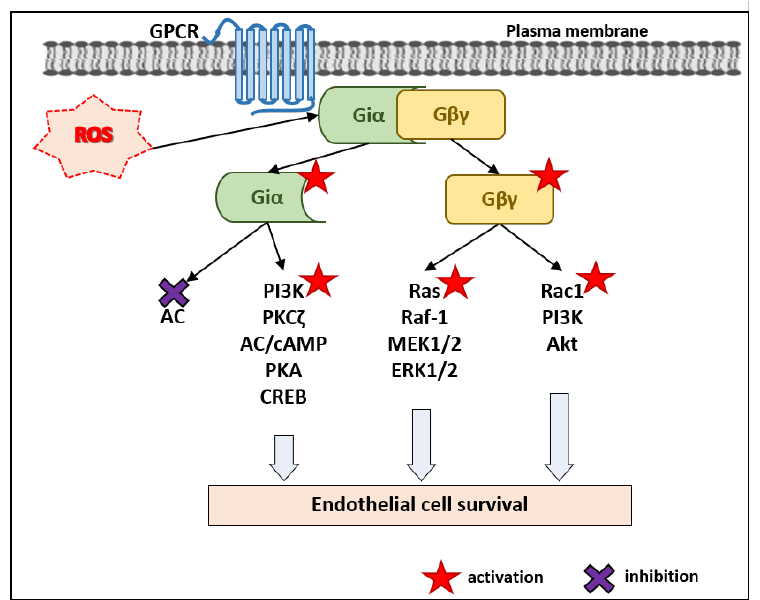
Figure 1. Scheme illustrating the potential mechanisms for activation of the pro-survival pathways by ROS-induced activation of G i proteins—both Gα i and Gβγ subunits—in a G i -PCR-independent manner. Table 1. Involvement of Gi proteins, activated by ligand binding to GPCRs, in regulation of EC survival, and apoptosis.